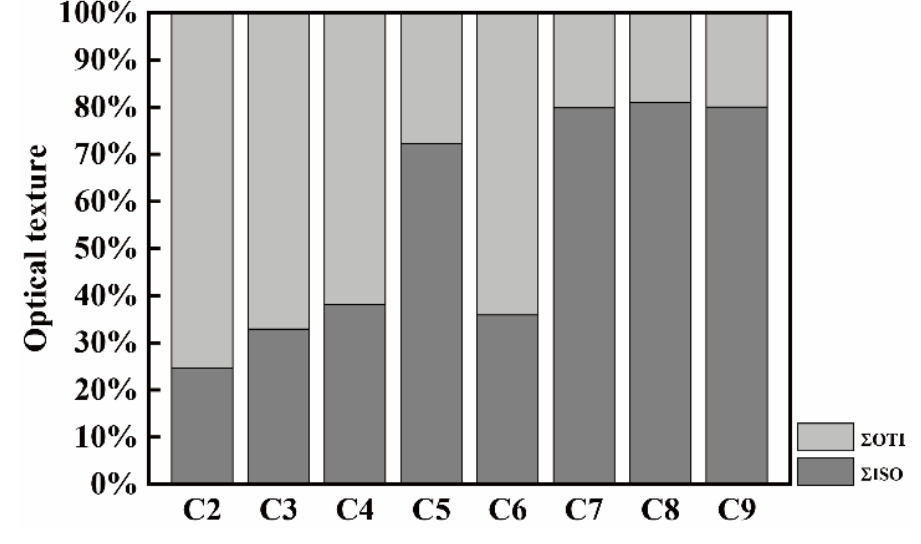
Materials 2021 , 14 , x FOR PEER REVIEW Figure 6. The optical texture of raw cokes. Figure 6. The optical texture of raw cokes.